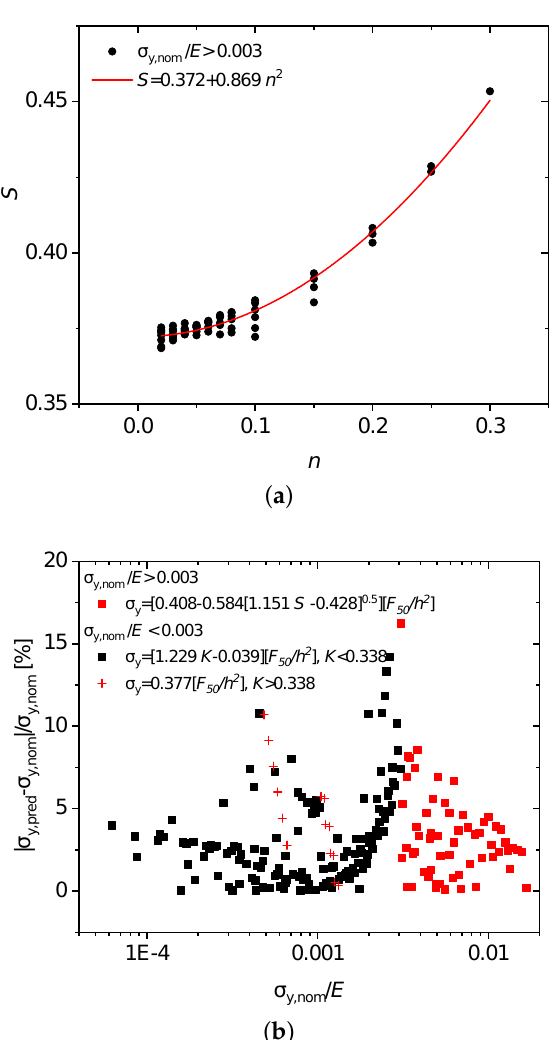
Figure 7. Predictive performance of the slope-dependent formula: hardening exponent n -dependence of the slope factor S ( a ), error percentage of the predicted SP yield stress vs. normalized proof stress σ y,nom / E ( b